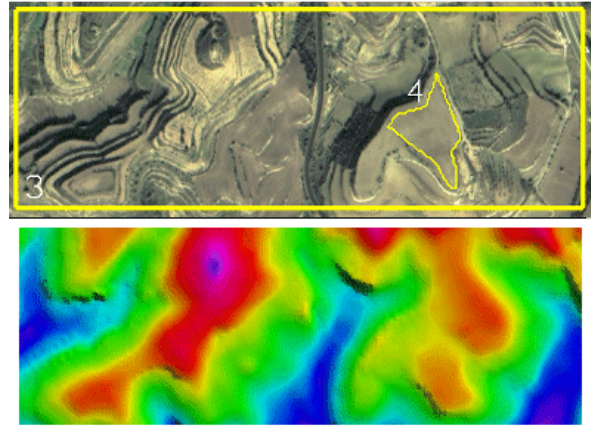
Figure 4. Above: test area 3, 1.3km x 0.5km, max. dh: 70m, including test area 4, 2ha, max dh: 10m. Below: Colour coded representation of the DSM.